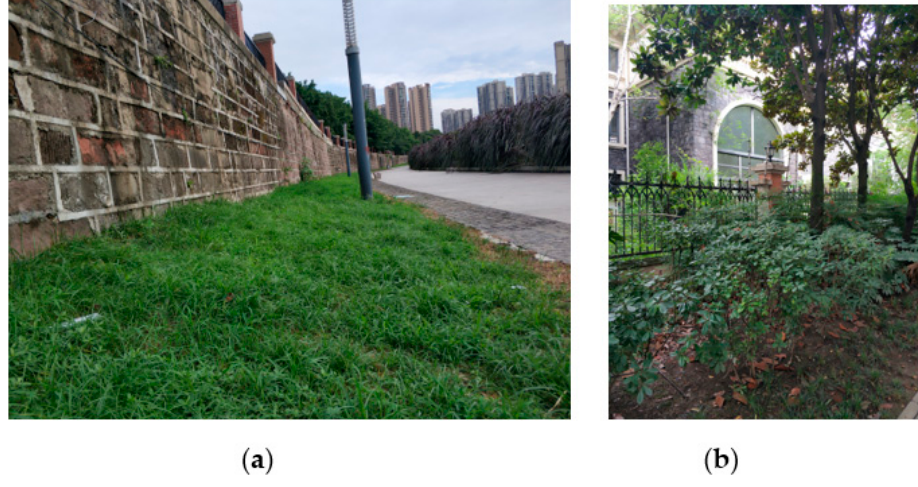
Figure 10. The real scene picture ( a ) road ( b ) residential area.